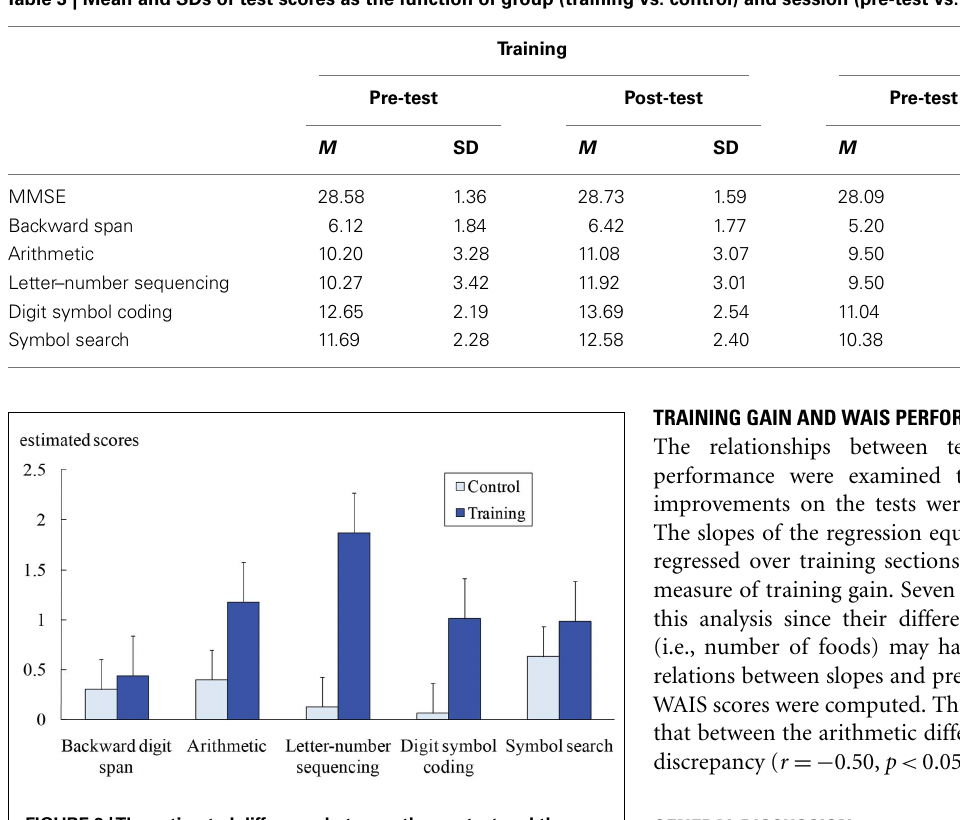
FIGURE 3 |The estimated difference between the pre-test and the post-test (i.e., post-test–pre-test, adjusted by pre-test performance) on backward digit span, arithmetic, letter–number sequencing, digit symbol coding, and symbol search tests as a function of training